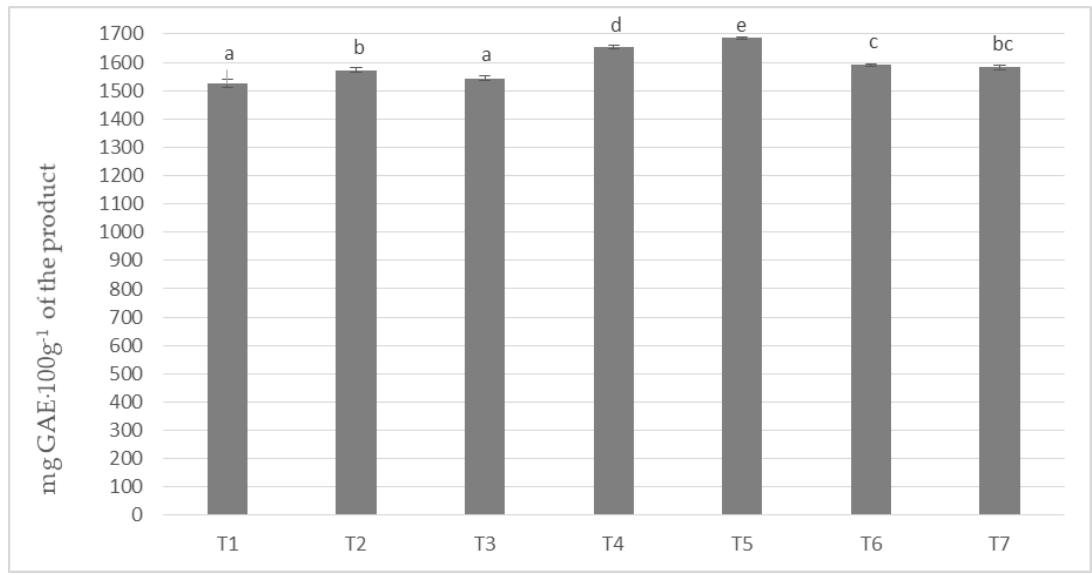
Figure 1. Polyphenols content in chocolate milk masses prepared from cocoa liquor from Peru (the same letter means that there are no statistically significant differences between the analyzed products at a confidence level of α = 0.05; the abbreviations used in the graph are described in Table 3) .